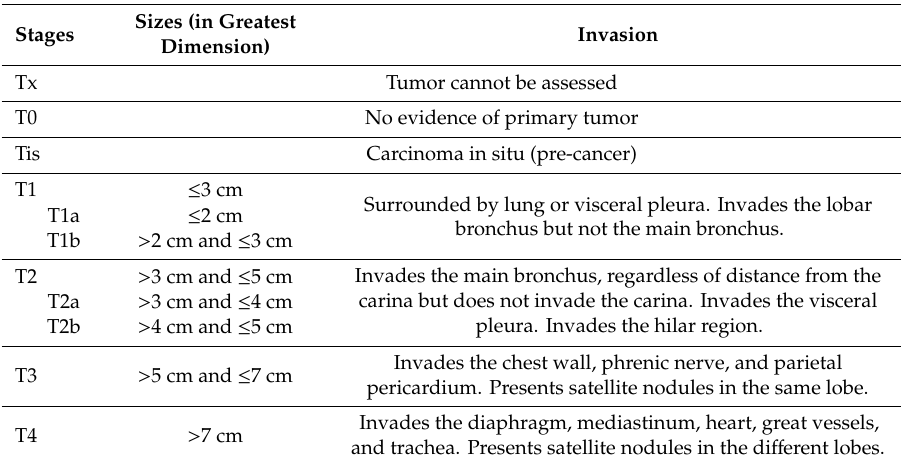
Table 1. T-staging of lung